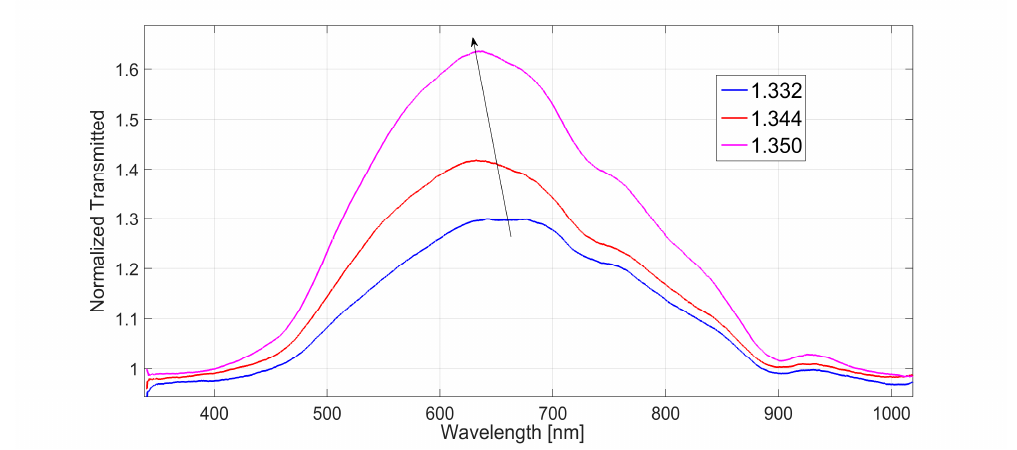
Figure 2. LSPR transmission spectra of the green plasmonic sensor obtained with three different water-glycerin